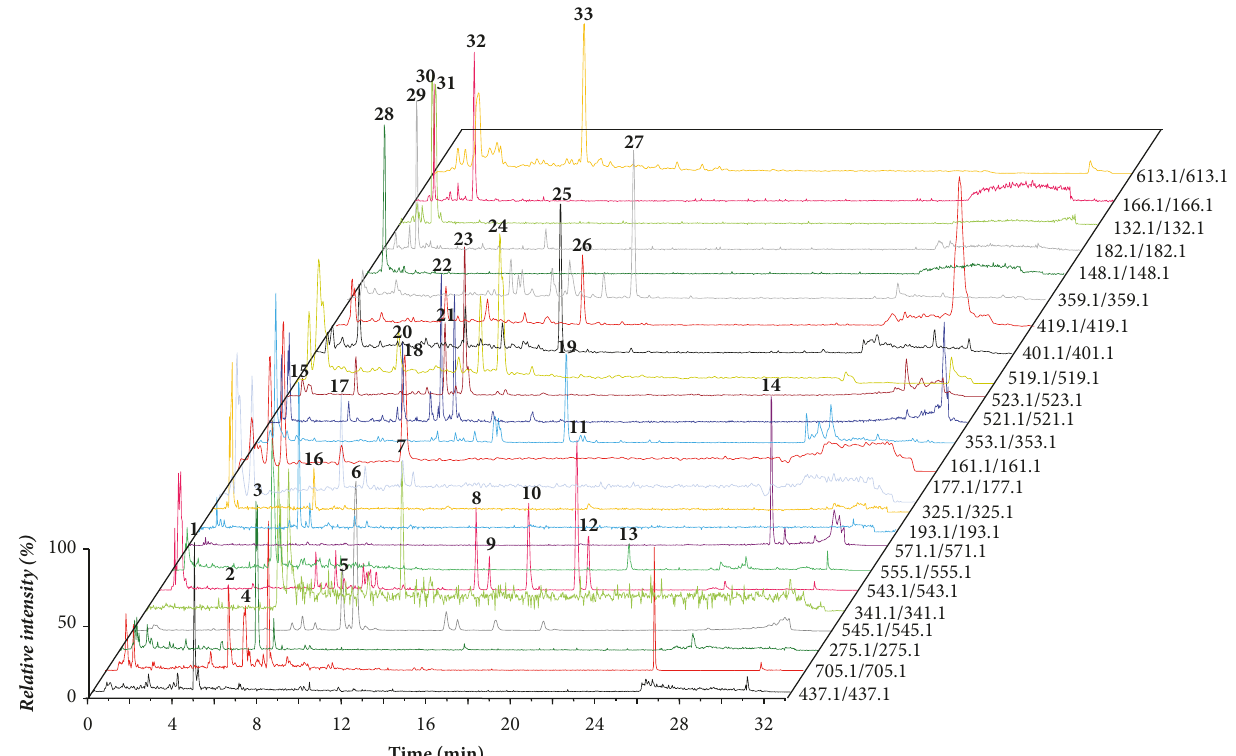
Figure 3: The extracted ion chromatogram (XIC) of the 33 components found to be significantly altered after being processed by vinegar or milk. All the ion pairs are monitored in positive mode except for 177.1/177.1, 161.1/161.1, 521.1/521.1, 523.1/523.1, 519.1/519.1, and 613.1/613.1. Compound number is consistent with the compound number in Table 1.